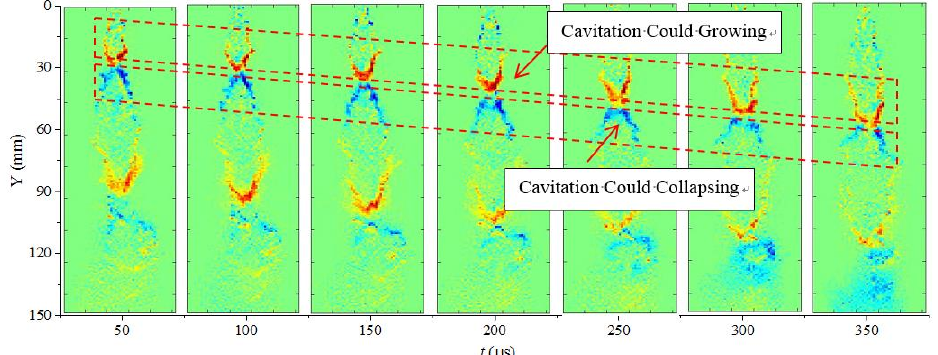
Figure 9. Cavitation process of experiment. Reprinted with permission from Ref. [31]. Copyright 2020, Mechanika.